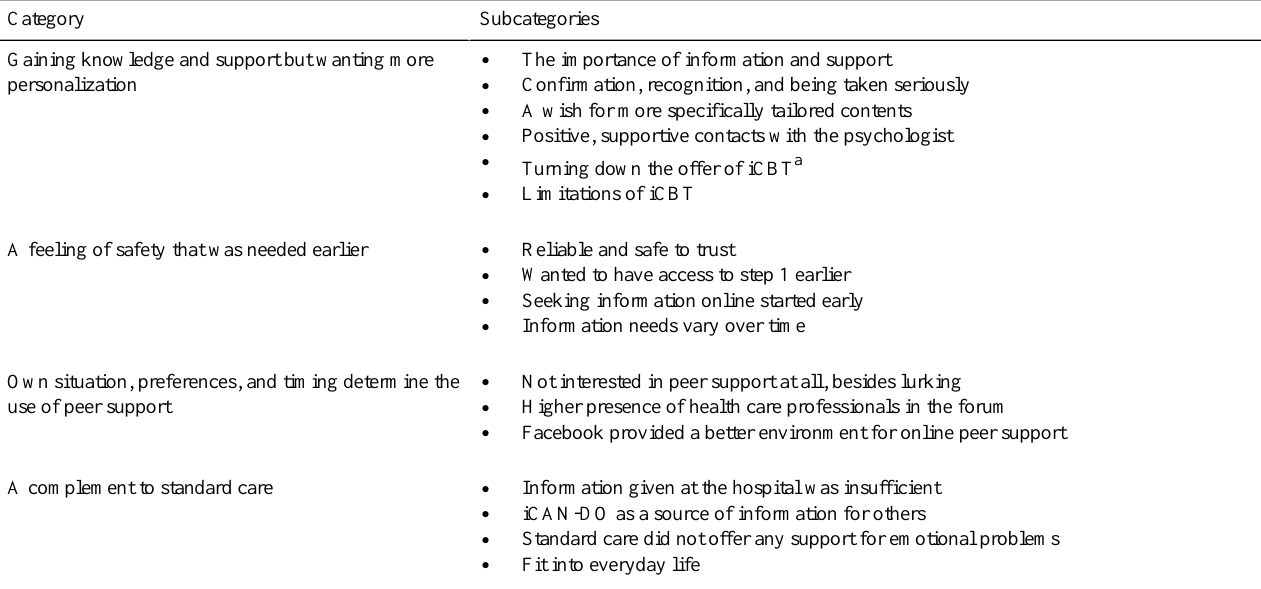
Table 4. Categories and